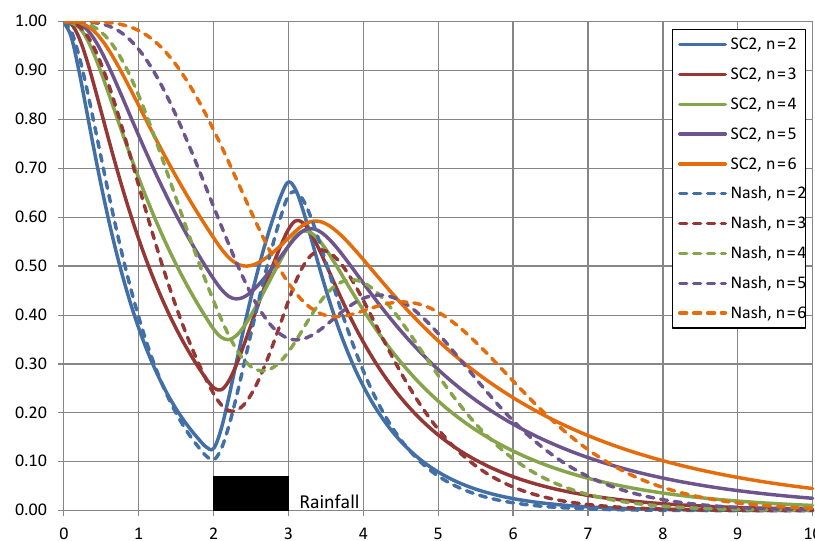
Figure 10. Comparison of the reaction of SC2 and Nash models to